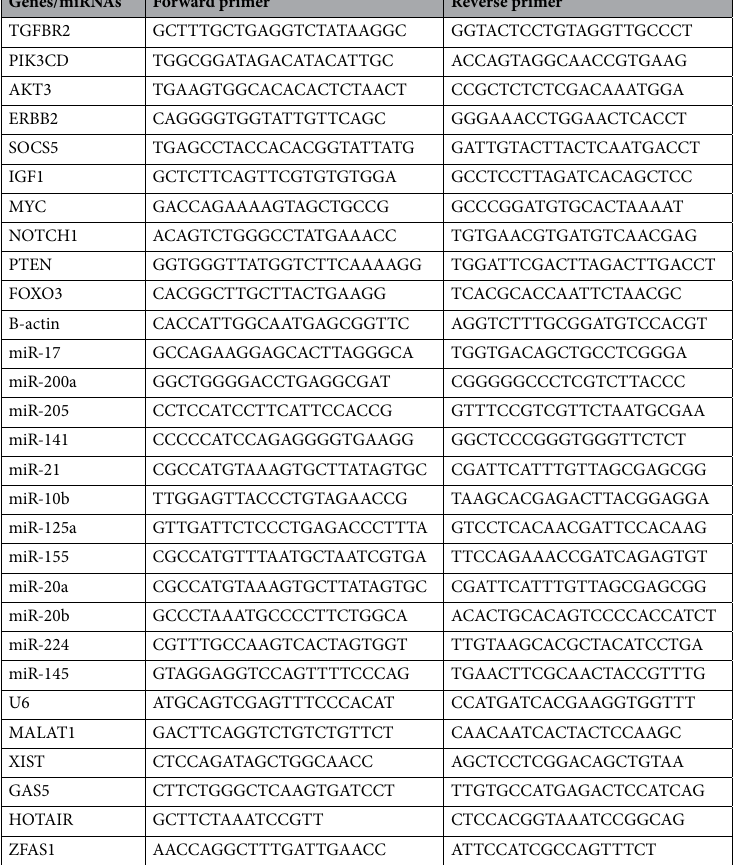
Primary outcomes. We measured the expression of the lncRNAs (Table 5), miRs (Table 1), and mRNAs (Table 4) as the primary outcomes before (baseline) and after three months of the intervention in the Aspirin and non-aspirin groups. Secondary outcomes. We evaluated the protein levels of TGFβ, IFNγ, IL-17, and IL-1β pre-and-post intervention (Table 7) as the secondary outcomes before (baseline) and after three months of the intervention in the Aspirin and non-aspirin groups. Evaluation of TGFβ, IFNγ, IL‑17, and IL‑1β proteins. ELISA test was used to evaluate the protein levels of TGFβ, IFNγ, IL-17, and IL-1β. The samples were first lysed using a lysis buffer. The protein levels of anti-TGFβ (ab193715, Sensitivity: 1.5 pg/ml, Range: 1.5–500 pg/ml), anti-IFNγ (ab174443, Sensitivity: 470 pg/ ml, Range: 0.468–30 ng/ml), anti-IL-17 (ab119535, Sensitivity: 0.5 pg/ml, Range: 1.6–100 pg/ml), and anti-IL-1β (ab46052, Sensitivity: 6.5 pg/ml, Range: 15.6–500 pg/ml) were determined by a sandwich ELISA as follows: aliquots of 100 μl/well (5–10 μg/ml; monoclonal antibody) of anti-TGFβ, anti-IFNγ, anti-IL-17, and anti-IL-1β were used to coat 96-well plates and incubated overnight at 4 °C. Plates were blocked with PBS containing 1% bovine serum albumin (BSA) for one hour at room temperature, followed by washing with washing buffer (PBS) containing 0.1% BSA plus 0.05% Tween 20. Supernatants were diluted at 1:4 or 1:2 with PBS and dispensed into the wells. To generate a standard curve, TGFβ, IFNγ, IL-17, and IL-1β, were used at a concentration range of 25 ng/ml diluted to 100 pg/ml in 10 serial dilutions in PBS plus 1% BSA. After 2-h incubation at room tem- perature, plates were washed, and 100 μl of 0.5 μg/ml of biotin anti-TGFβ, anti-IFNγ, anti-IL-17, and anti-IL-1β antibodies were added to each well. After two-hour incubation at room temperature, plates were thoroughly washed, and 100 μl of a 1:10,000 dilution of peroxidase-streptavidin conjugate were added to each well. Plates were incubated at room temperature for one hour. After washing off the unbound antibody, 100 μl of TMB- peroxidase substrate/chromogen solution was added to each well and incubated for 10–20 min. The reaction was stopped with 100 μl of 1 M H 3 PO 4 . An automated ELISA reader determined absorbance at 450 nm. Real‑time PCR analysis. The RNA was extracted from the plasma samples. Plasma (250 μl) was added to 750 μl TRIzol (Beijing Tiangen Biotech Co., Ltd.). RNA extraction was then carried out according to the manu-